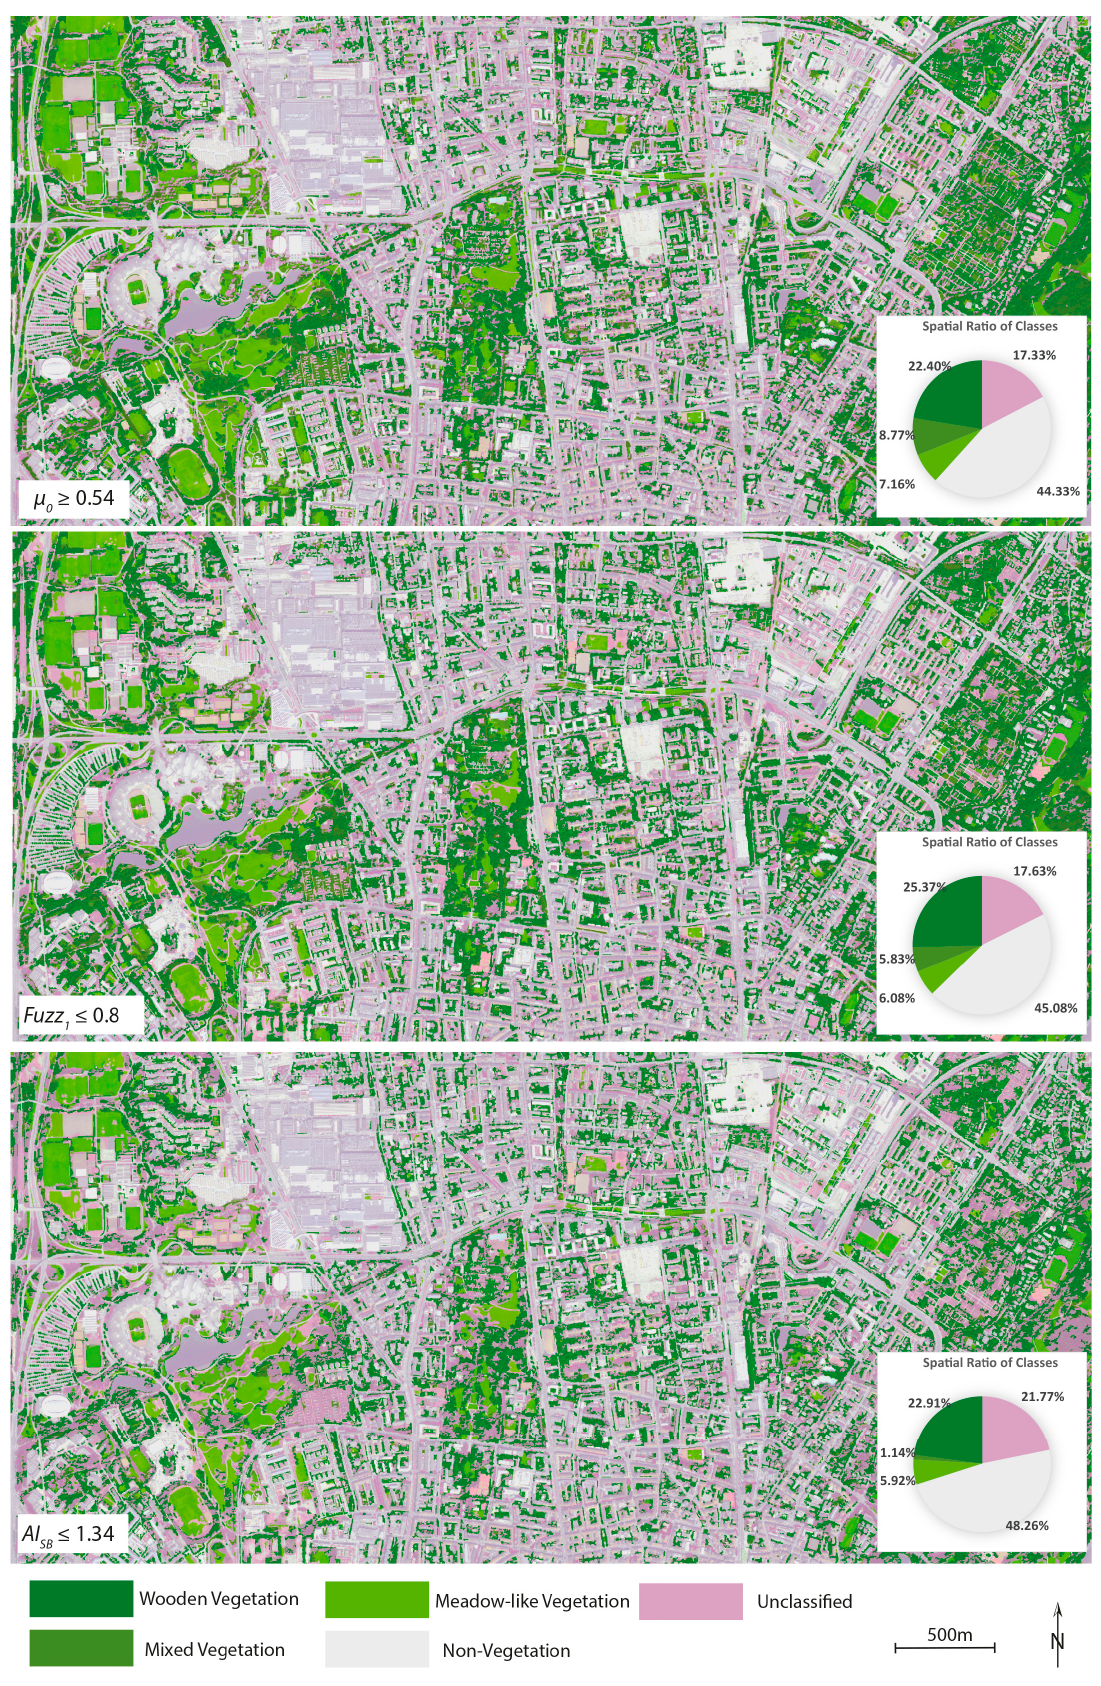
Figure 10. Crisp classification results after defuzzifying fuzzy classified objects of a WV-2 scene of Munich by applying the 80%-quantile defuzzification rules ( µ 0 ≥ 0.54, Fuzz 1 ≤ 0.80 and AI SB ≤ 1.34) and their respective area coverage.